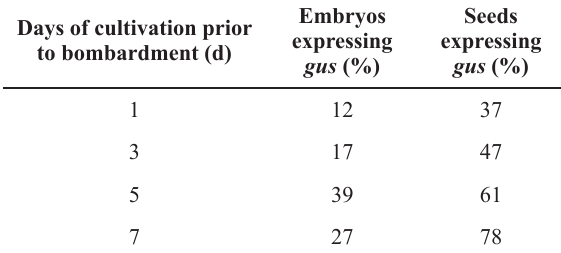
Expression of gus in isolated embryos and seeds of Brachiaria brizantha cv. Marandu, 75 explants per treatment cultivated before bombardment on induction medium M1.2 for different periods of time, evaluated 48 h after bombardment with pAct1-D.